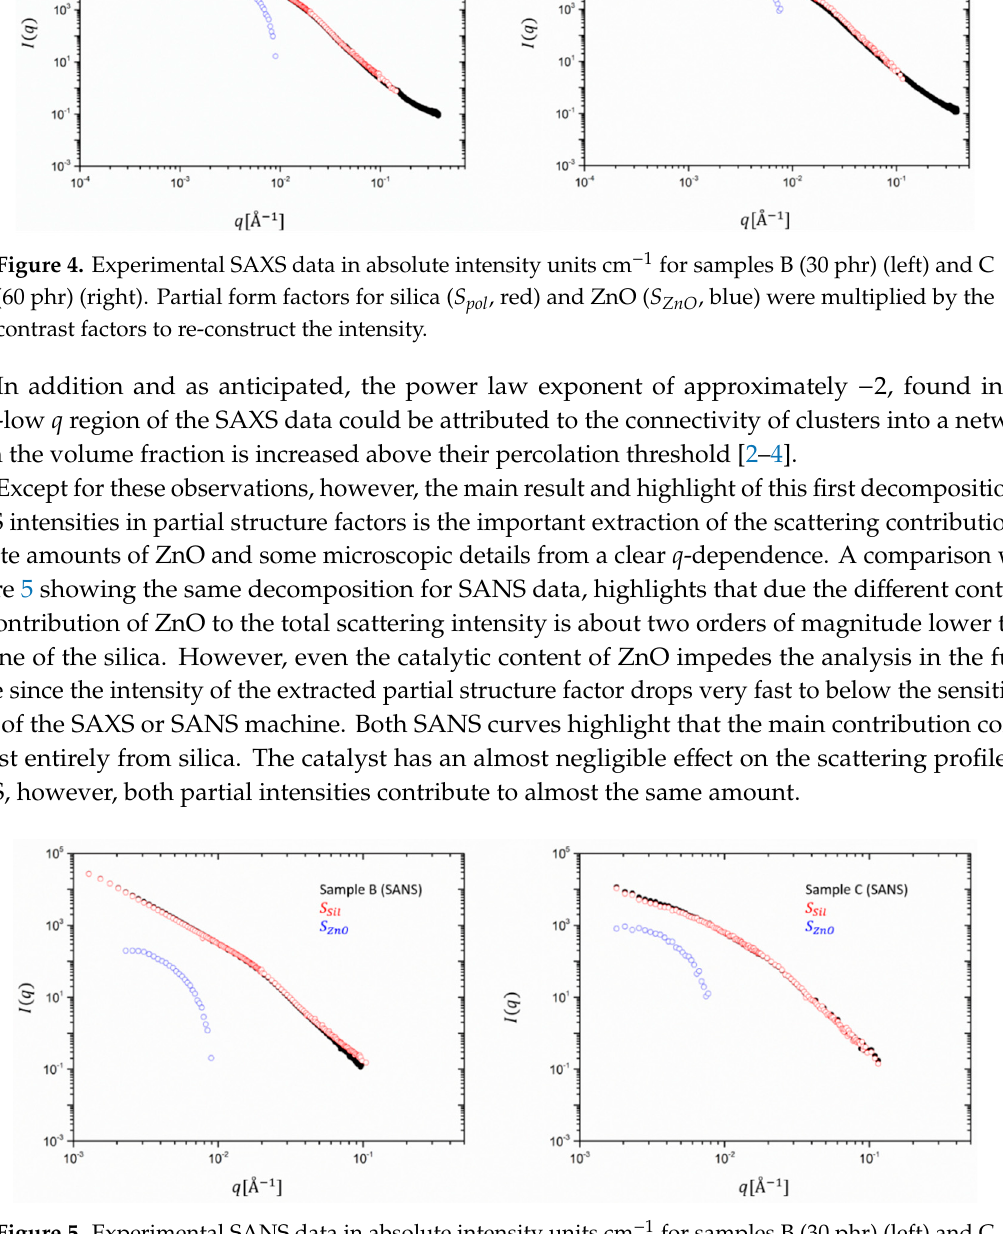
Figure 4. Experimental SAXS data in absolute intensity units cm − 1 for samples B (30 phr) (left) and C (60 phr) (right). Partial form factors for silica ( 𝑆 (cid:3043)(cid:3042)(cid:3039) , red) and ZnO ( 𝑆 (cid:3027)(cid:3041)(cid:3016) , blue) were multiplied by the contrast factors to re-construct the intensity.